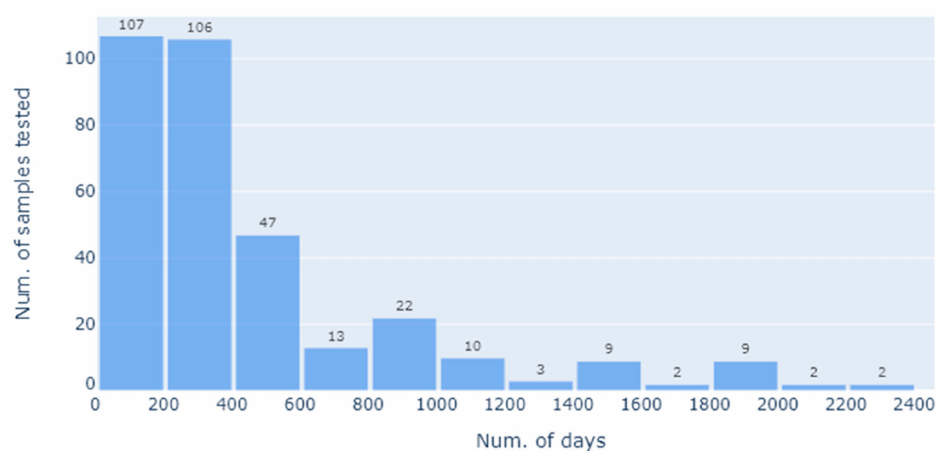
Figure 2. Histogram showing the time between the last Equivac ® HeV Hendra virus vaccination and the sampling date for the SNT, with the count being the number of samples tested at that time point (in days); days are grouped for convenience 1–200; 201–400; 401–600,